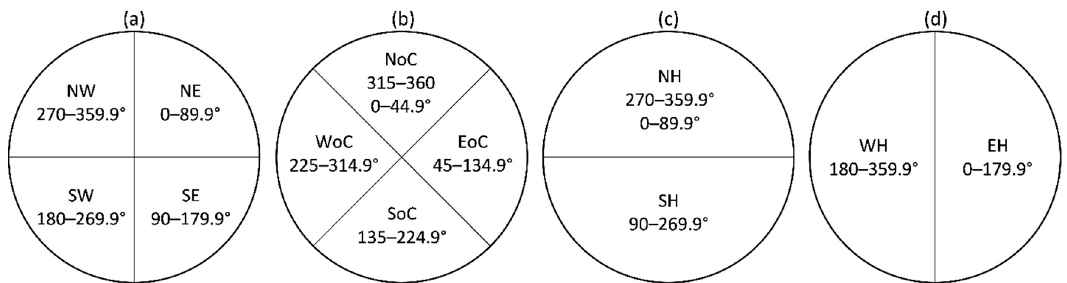
Figure 1. Illustration of the TC environment (circles) stratified into the different regions analyzed in this study. ( a ) shows the northeast (NE), southeast (SE), southwest (SW), and northwest (NW) sections; ( b ) shows the north of center (NoC), east of center (EoC), south of center (SoC), and west of center (WoC) sections; ( c ) shows the north half (NH) and south half (SH) sections; and ( d ) shows the west half (WH) and east half (EH) sections. The numerical ranges in degrees that define the sections are provided. All sections are defined relative to north.